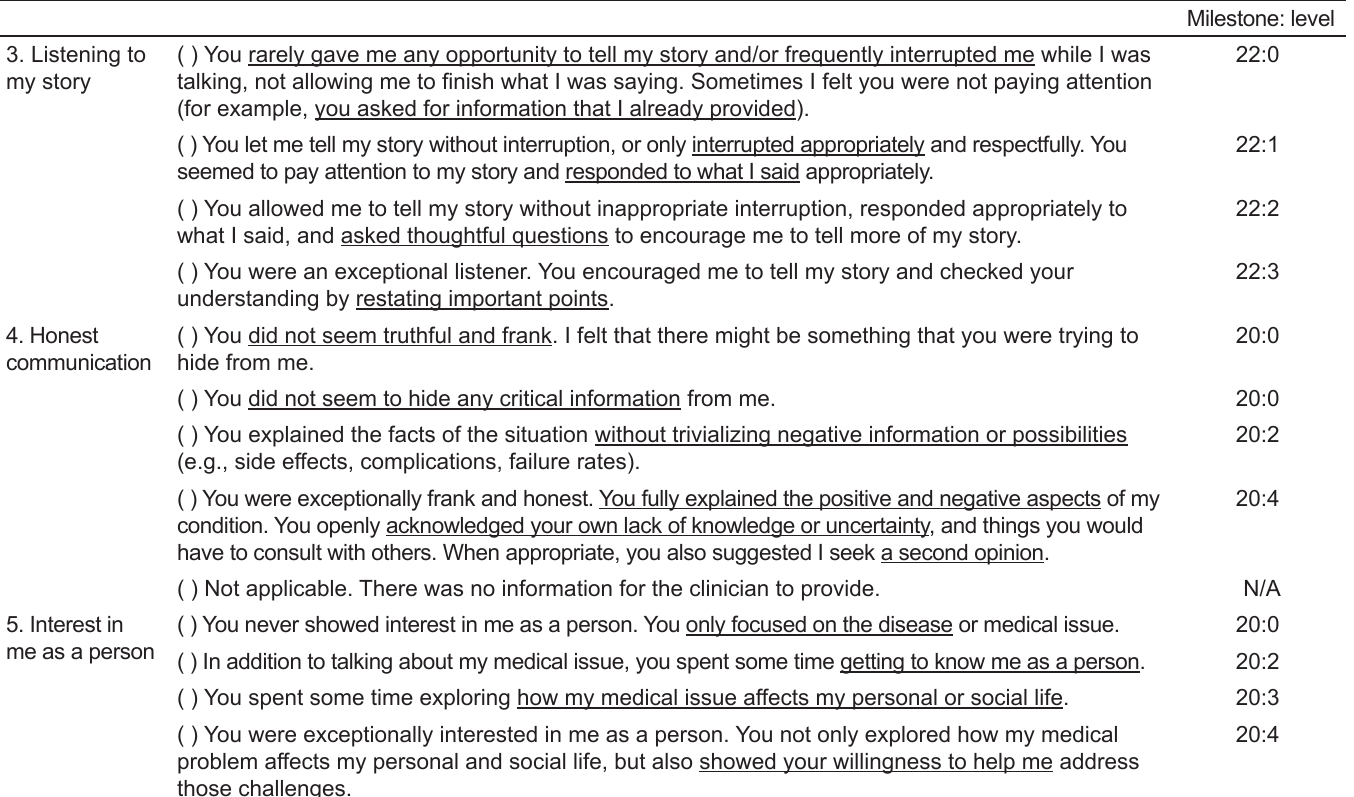
Table 1. Snapshot of RUCIS, a behaviorally-anchored rating scale mapped to milestones. (For quick reference to Milestone description and anchors, please use this link: https://www.acgme.org/Portals/0/PDFs/Milestones/